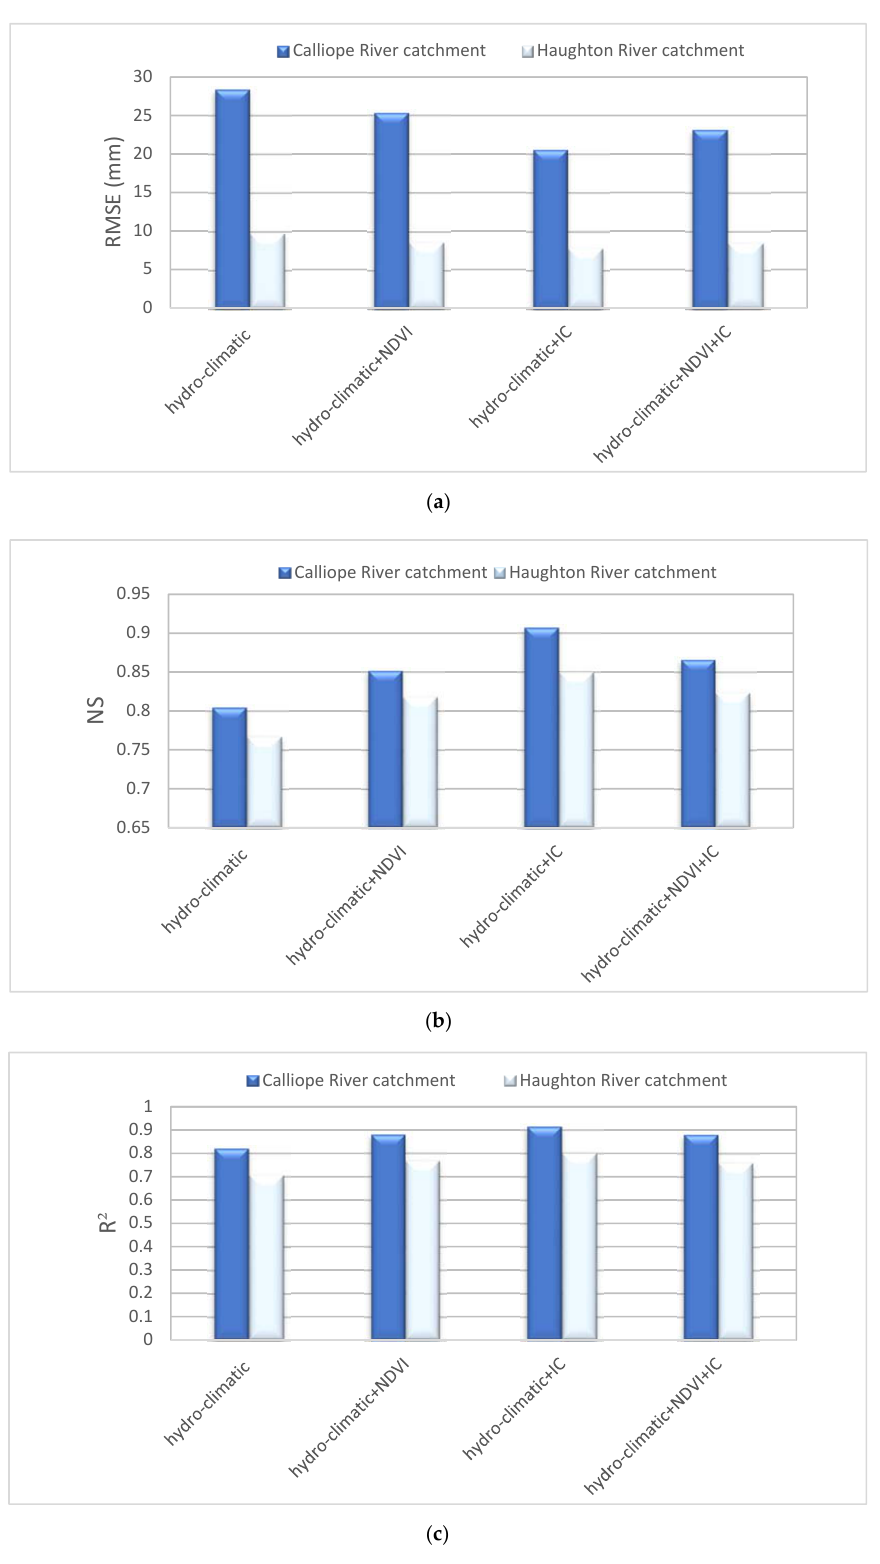
Figure 5. Comparison of average of performance indices (root mean squared error (RMSE), Nash–Sutcliffe model performance coefficient (NS), and coefficient of determination (R 2 )) for the ANN model with different input patterns in the validation period for Haughton River and Calliope River catchments ( a – c ).